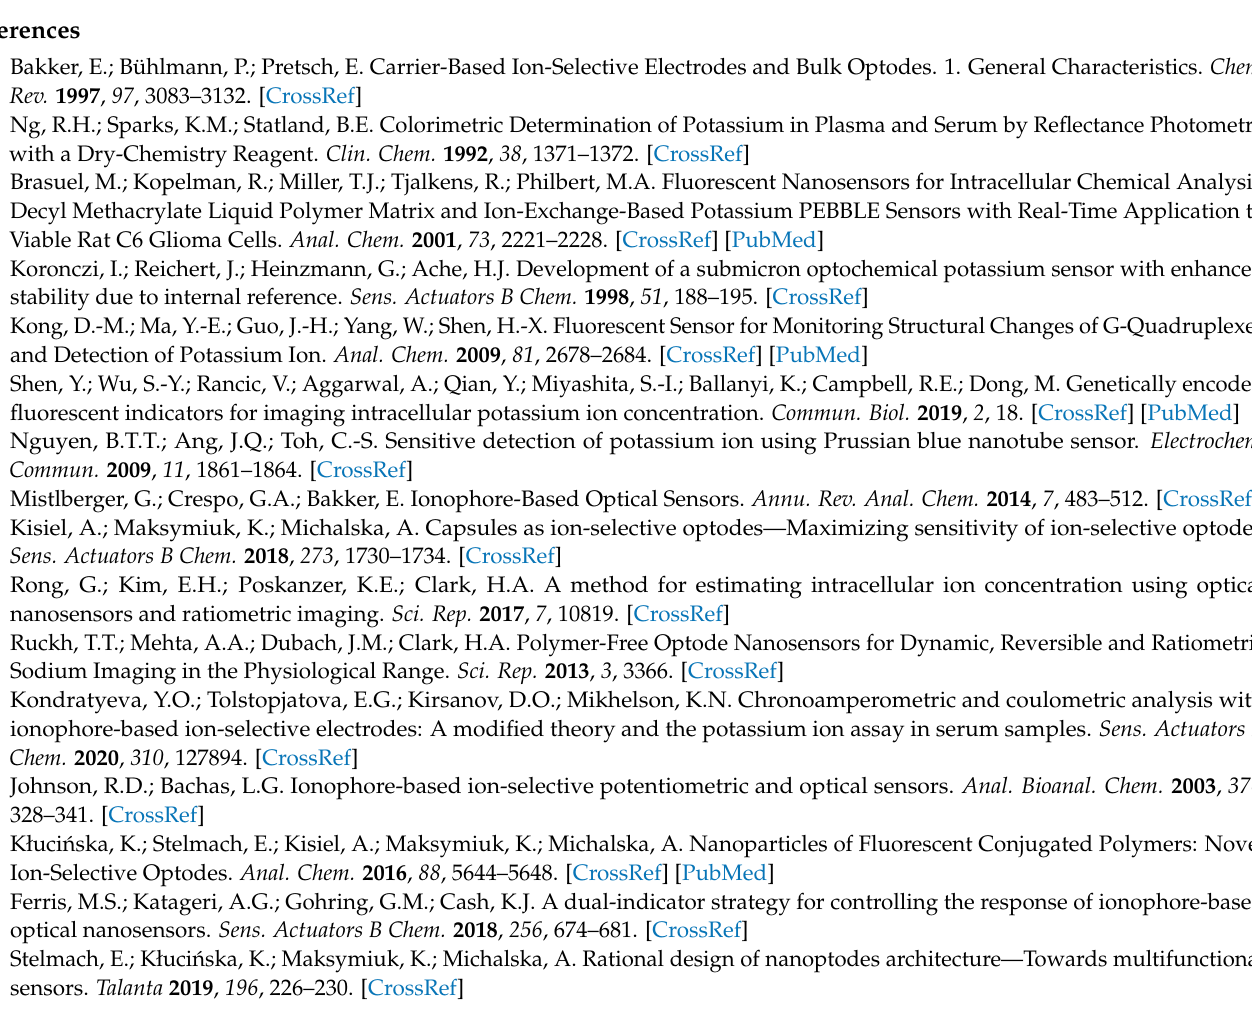
1H NMR spectra for SD; Figure S3: 13C NMR spectra for SD; Figure S4: Mass Spectroscopy for SD; Figure S5: Transmission electron microscopy (TEM) and dynamic light scattering (DLS) image for the nanospheres; Figure S6: The fluorescence microscope images of cation exchange resin adsorbed different